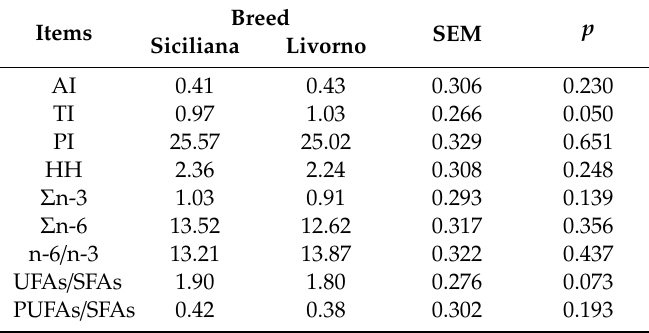
Table 5. Nutritional indices and ratios of egg